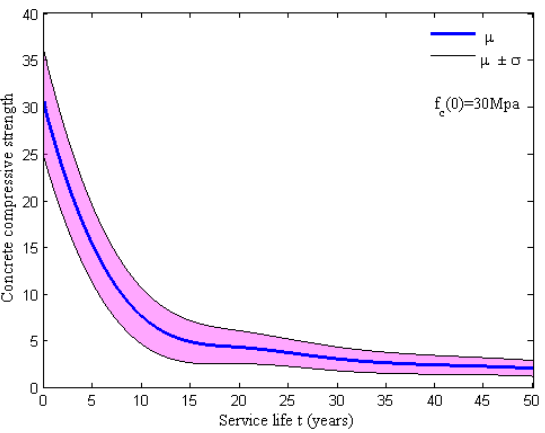
Figure 7. Time variance of the compression strength of unconfined concrete.